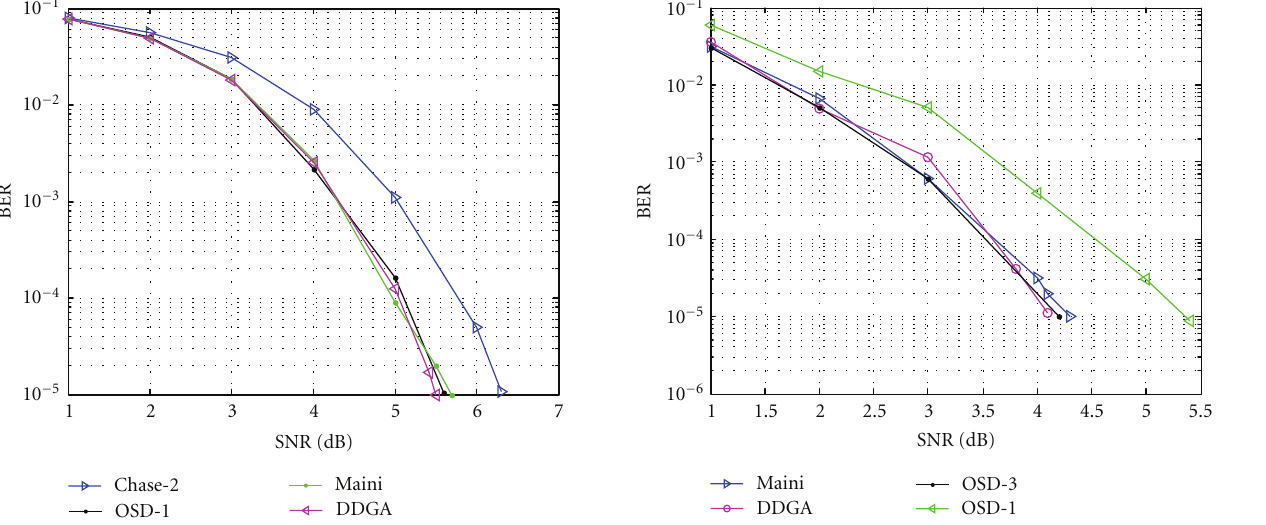
Figure 18: Performances of Chase-2, OSD-1, Maini, and DDGA algorithms for BCH (127,113,5) code.